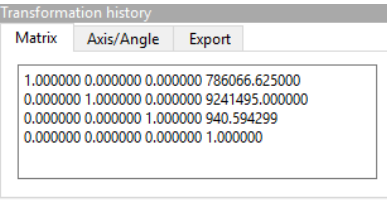
Figure 11. 3D Matrix Transformation in